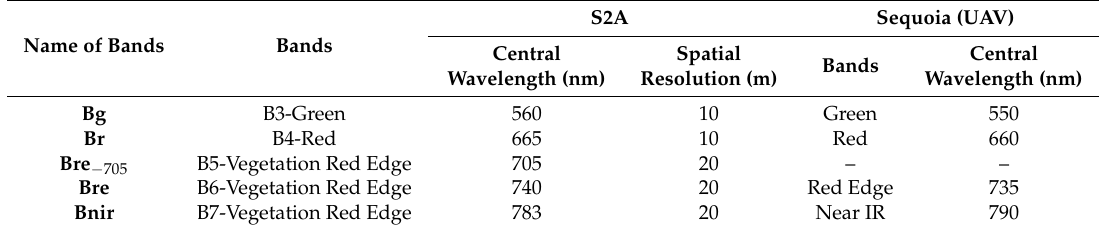
Table 1. The corresponding relationship between S2A data and UAV